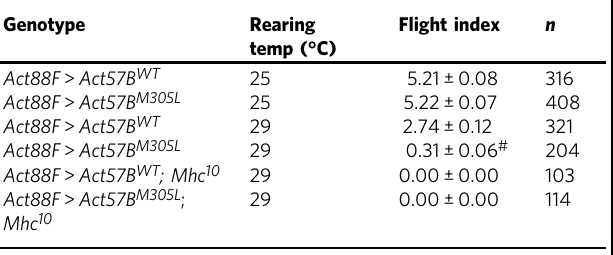
Table 4 Percent of motile wildtype and mutant actin – Tpm fi laments determined from in vitro analysis.